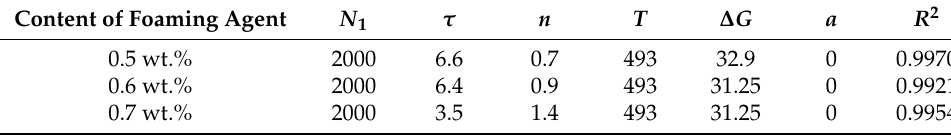
Table 4. Influence of the content of the foaming agent on the